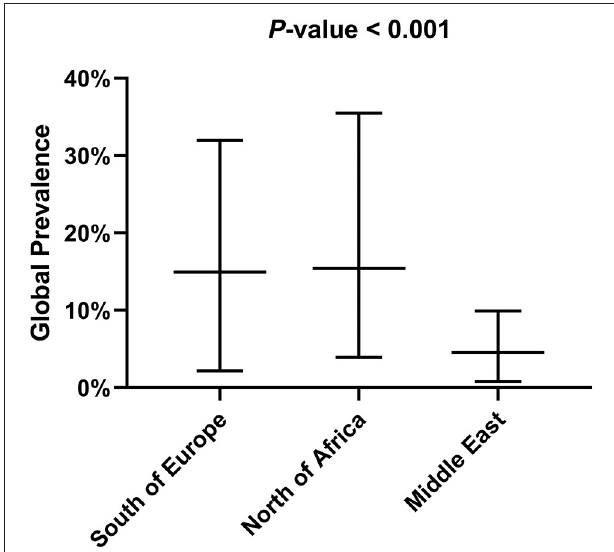
FIGURE 2 | Global prevalence of infection in rodents depending on the geographical